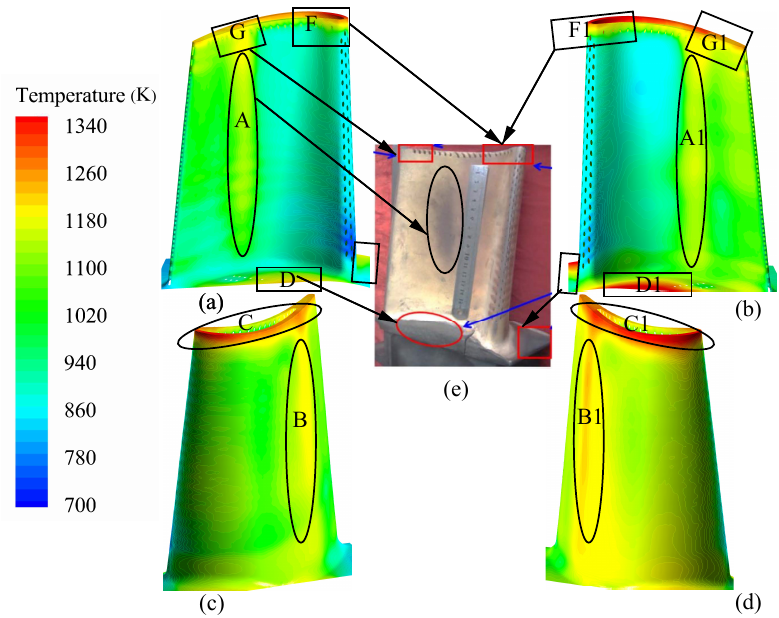
Figure 7. The temperature distribution of the blade: ( a ) pressure side and ( c ) suction side under the rotating condition; ( b ) pressure side and ( d ) suction side under the stationary condition; ( e ) the pressure side of actual service moving blade (Reprinted with permission from Ref. [32], 2021, Cai et al.) (A(A1)–G(G1) represent the local high-temperature